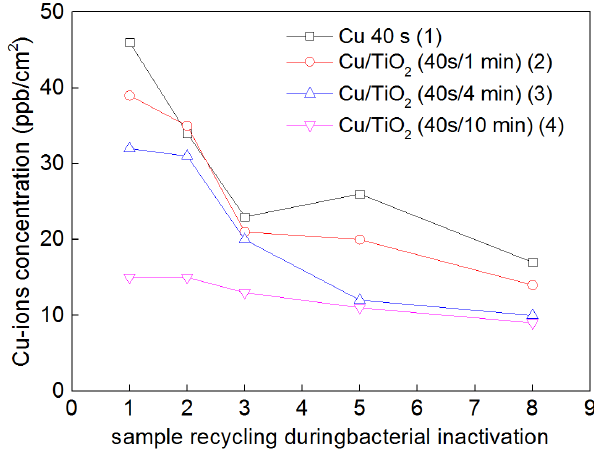
Figure 4. Cu ions release from diverse Cu ‐ cotton and TiO 2 /Cu ‐ cotton sputtered films as a function of catalyst cycling up to the 8th cycle. Coatings 2017 , 7 , 20 14 of 28